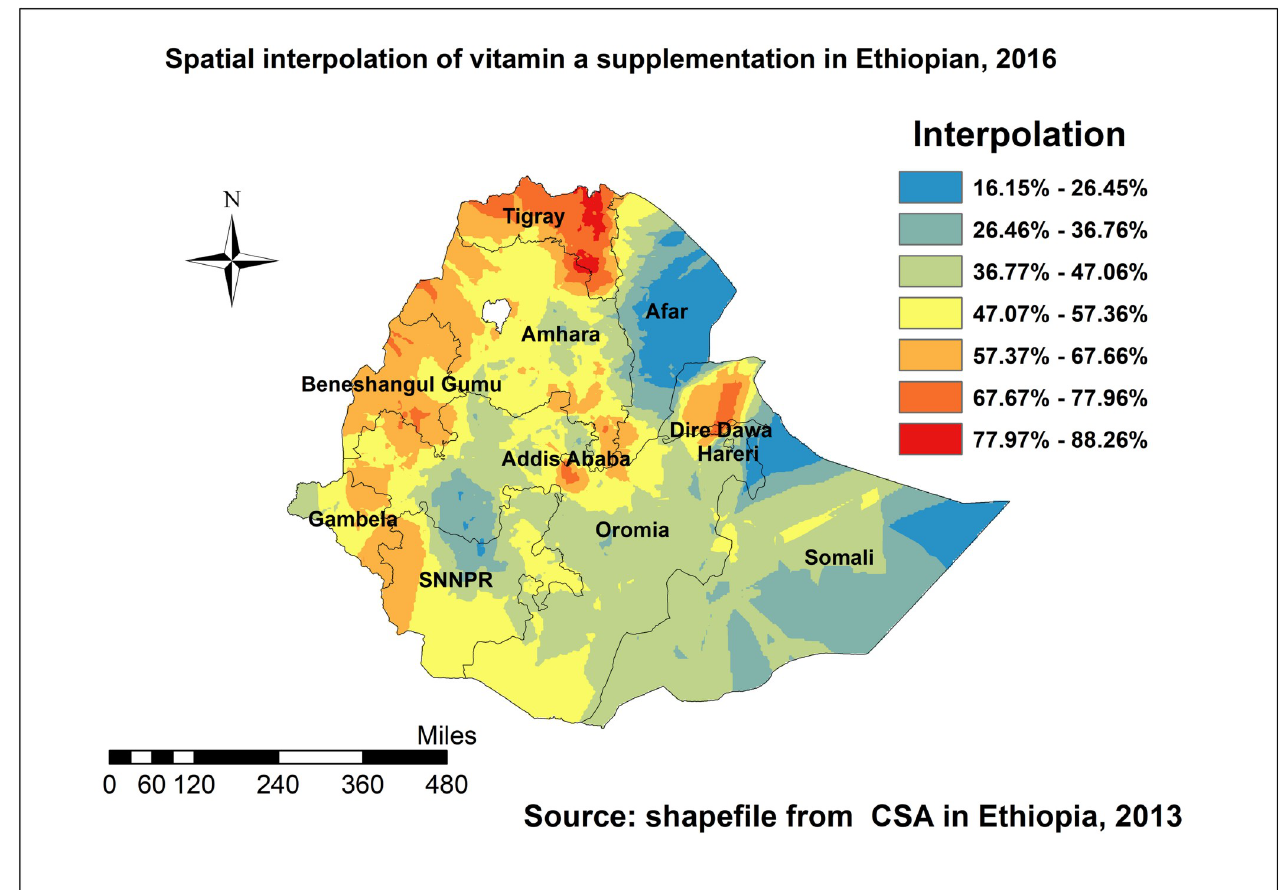
Fig 3. Ordinary kriging interpolation of vitamin A supplementation among children aged 6–59 months in Ethiopia, EDHS 2016.